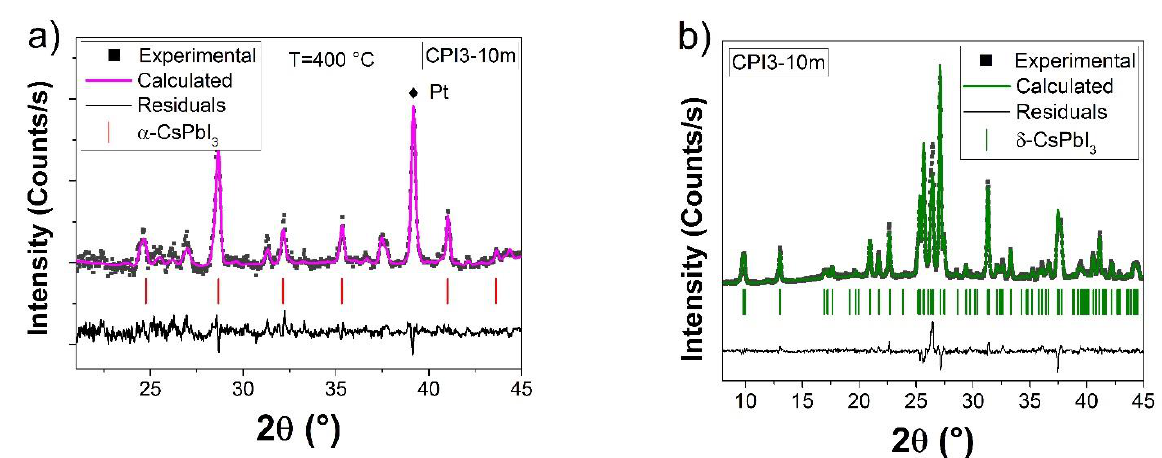
Figure 1. Rietveld refinement of sample CPI3-10 m at 400 °C ( a ) and at room temperature ( b ). refers to Experimental pattern, color line is the pattern calculated by Rietveld refinement, in Black line the residuals between experimental and calculated pattern, the vertical bar indicates the theoretical peaks characteristic of α and δ-CsPbI 3 .